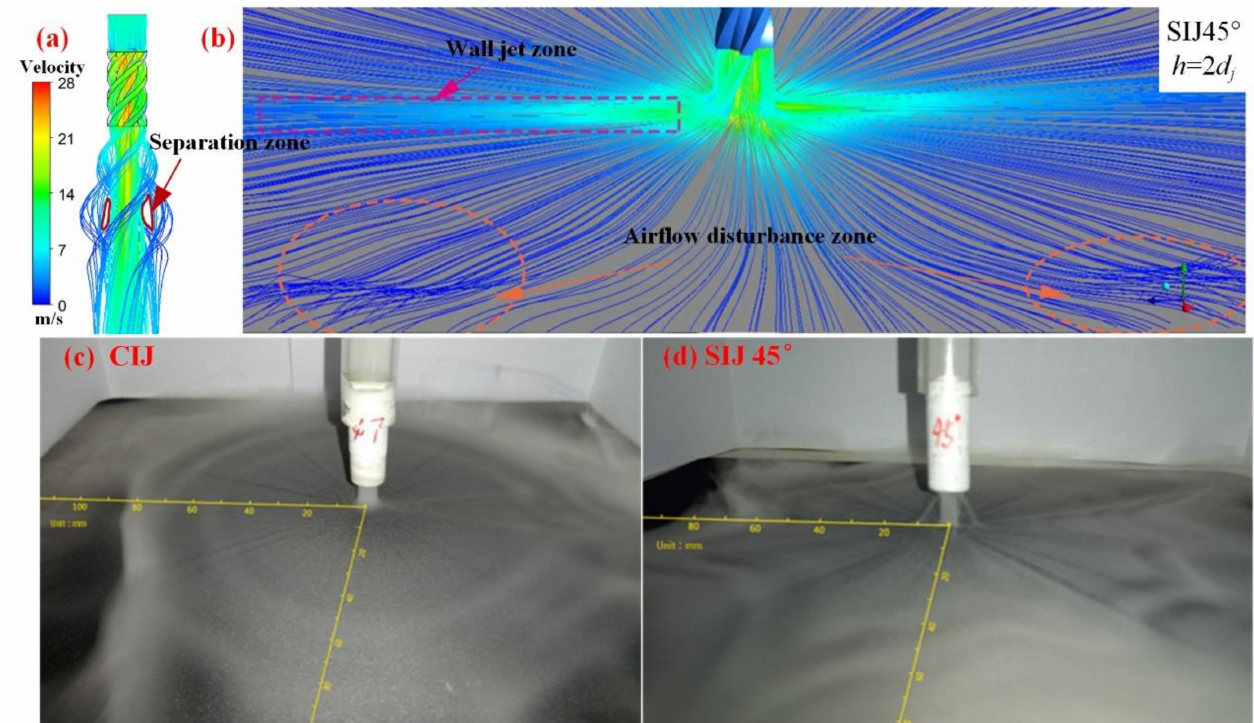
Figure 10. Three-dimensional (3D) streamlines of SIJ 45 ◦ in ( a ) nozzle outlet and ( b ) target surface. Smoke flow field with ( c ) CIJ and ( d ) SIJ 45 ◦ ( Re = 6000, h/d j =